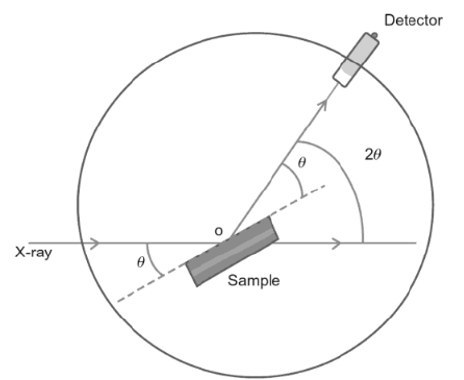
Figure 13. XRD instrumentation diagram [62].